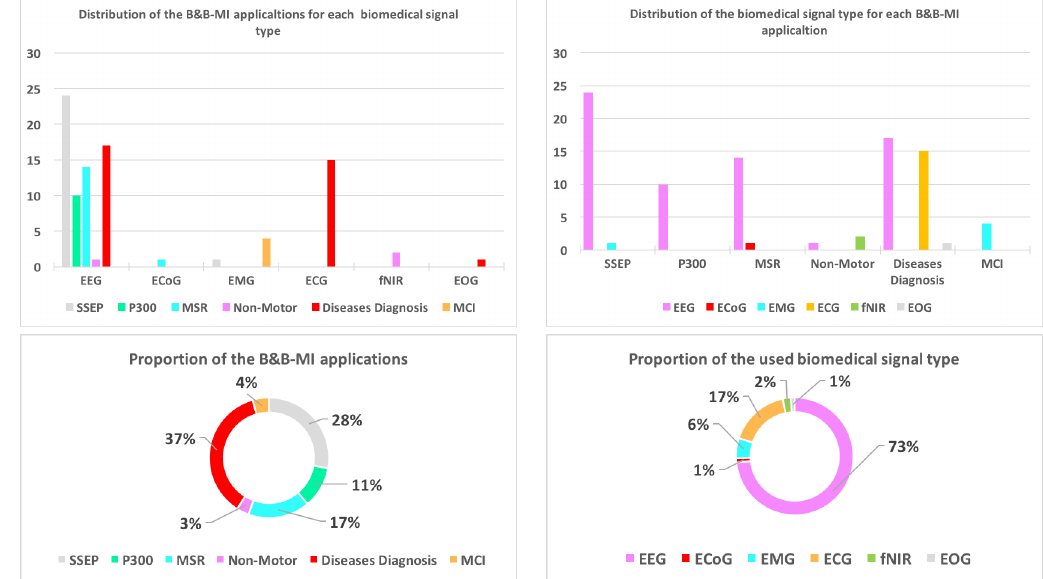
Figure 13. Distribution of the BBMI papers reviewed in this